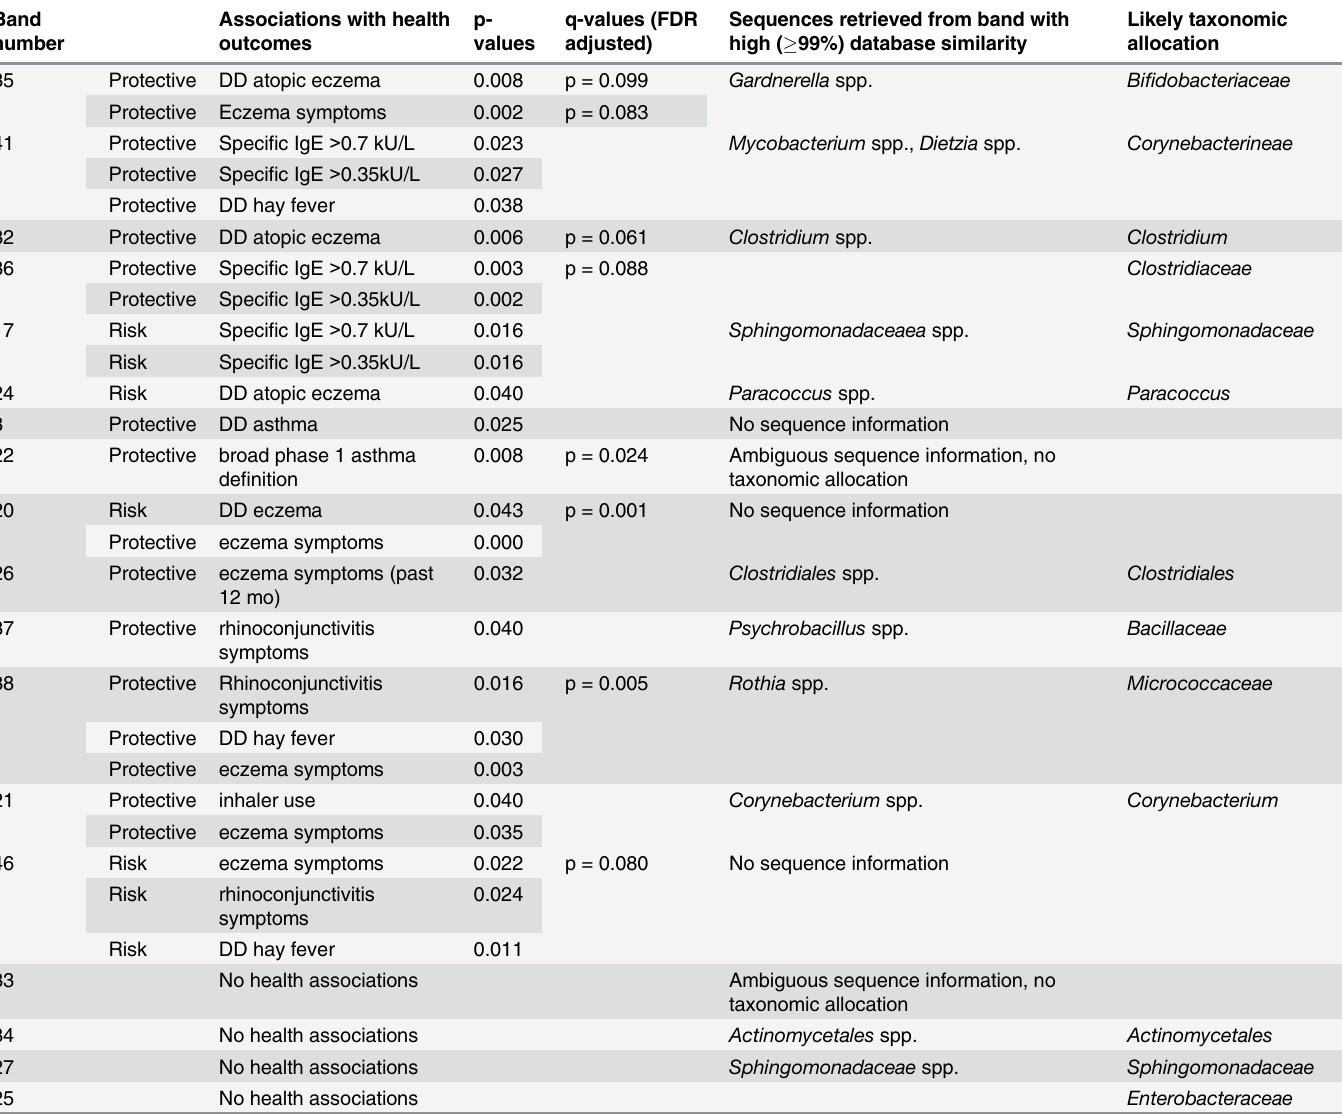
Table 3. Detailed information on health associations of DGGE bands that were selected for sequencing and taxonomic allocation of sequences retrieved from the bands after database comparison (p-values of associations between DGGE bands and health outcomes are provided both after crude analyses and after FDR adjustment for multiple